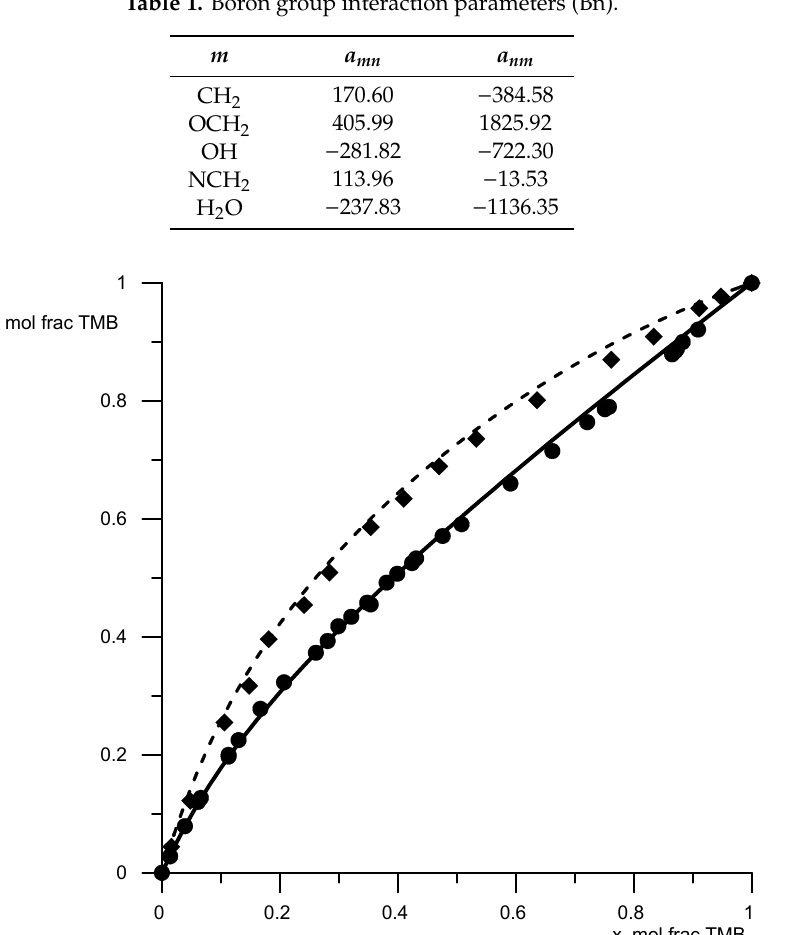
Table 1. Boron group interaction parameters (Bn).